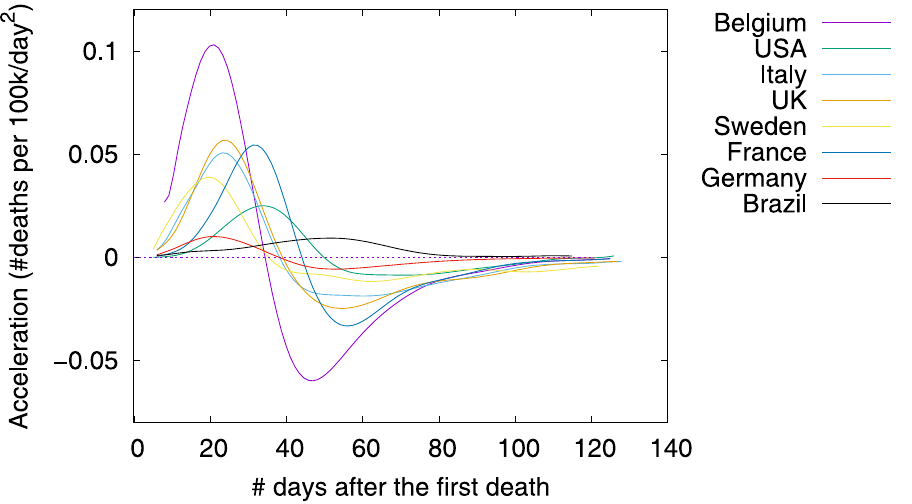
Fig 3. COVID-19 acceleration (second-order derivative), as of June 5th